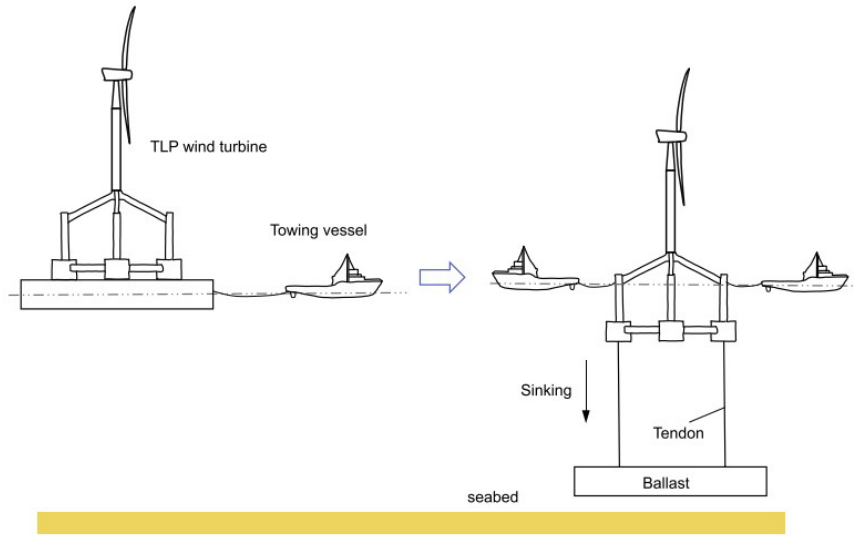
Figure 5. Installation of a GICON TLP (Jiang,